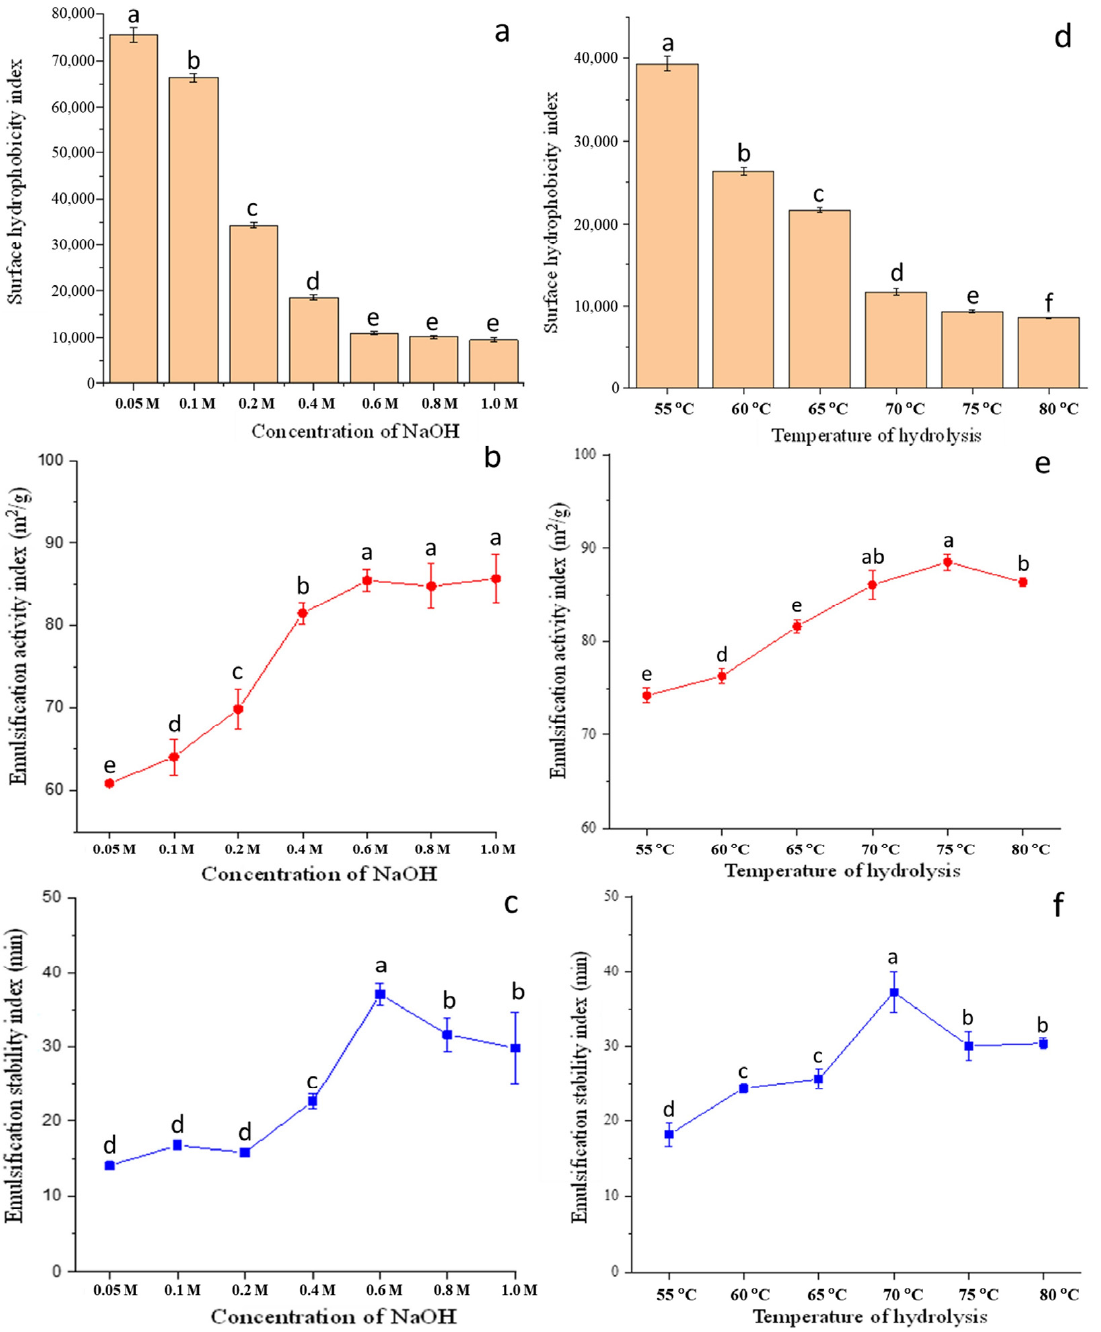
Figure 1. Surface hydrophobicity ( a ), emulsification activity index, ( b ) and emulsification stability index ( c ) of ZHCs and surface hydrophobicity ( d ), emulsification activity index, ( e ) and emulsification stability index ( f ) of ZHTs (n = 3). Different lowercase letters indicate a significant difference ( p < 0.05).